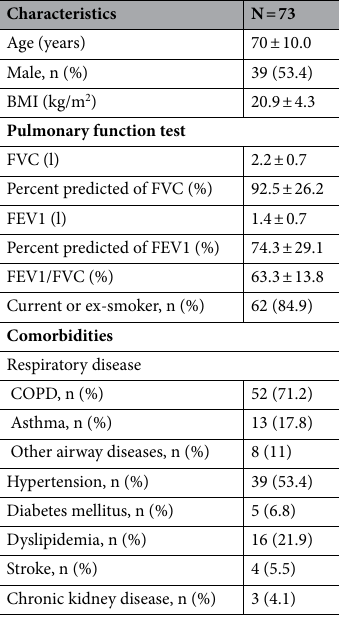
Table 2. Baseline characteristics of the studied population. BMI body mass index, COPD chronic obstructive pulmonary disease, FEV1 forced expiratory volume in 1 s, FVC forced vital capacity.